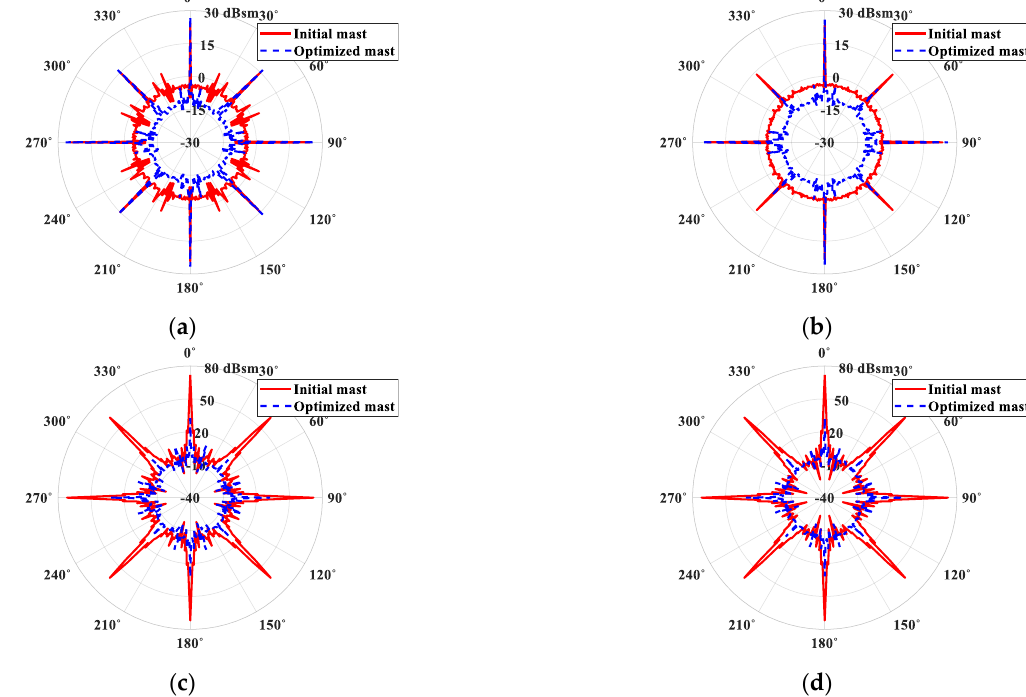
Figure 8. RCS pattern of the integrated mast in the azimuth plane in the X-band. ( a ) HH polarization at an elevation angle of 0°, ( b ) VV polarization at an elevation angle of 0°, ( c ) HH polarization at an elevation angle of 10°, ( d ) VV polarization at an elevation angle of 10°.